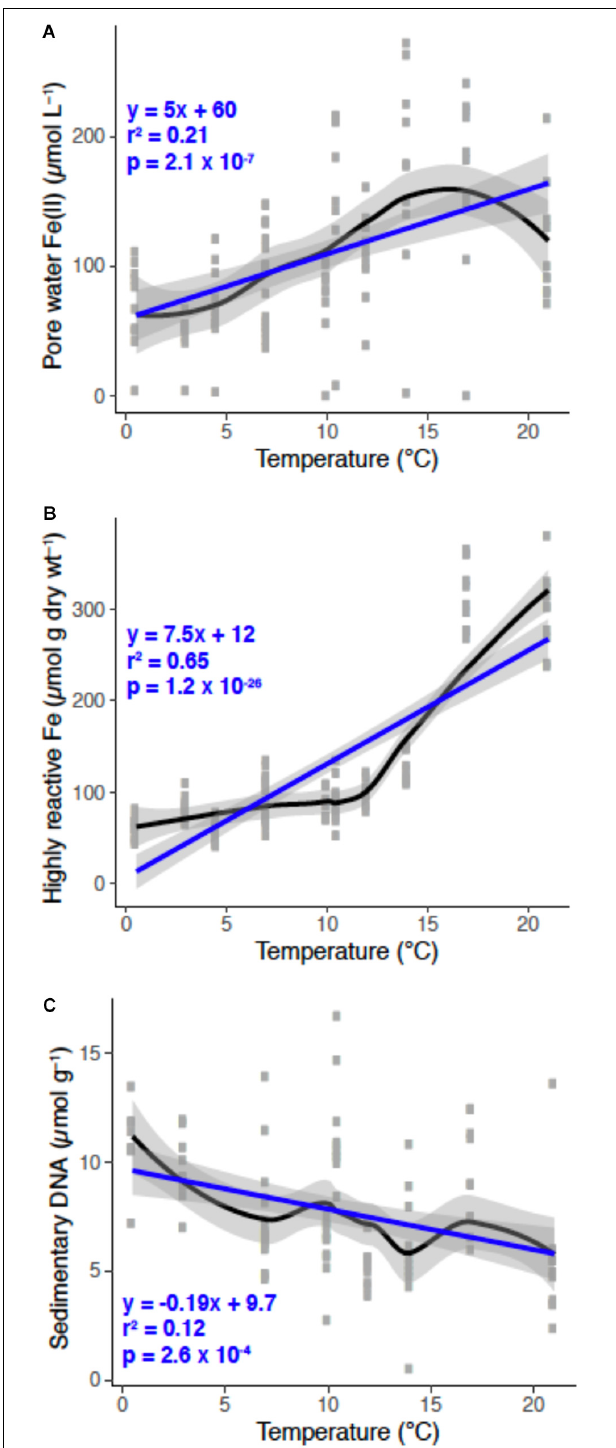
FIGURE 3 | Porewater Fe(II; A) , highly-reactive Fe (B) , and sedimentary DNA (C) pools as a function of temperature over the annual cycle at “The Eddy.” Individual data points are gray for each sampling event over the year. Black and blue lines are a loess smooth and a generalized linear model fit, respectively, and gray shading represents the 95% confidence interval for each line fit. The linear model statistics and equation are in blue